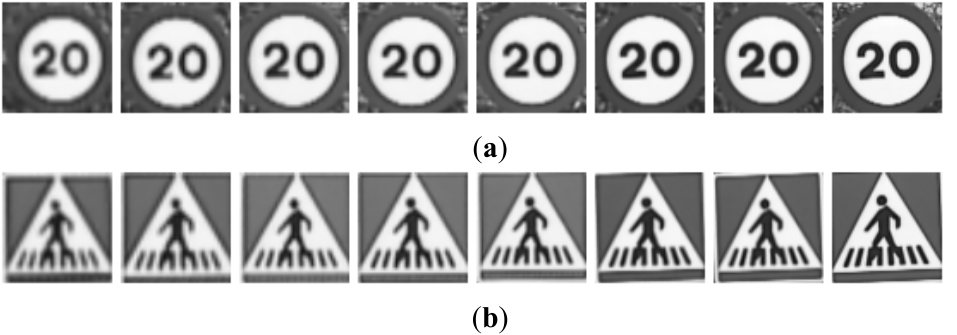
Figure 3. Examples of candidates in Figure 2 after resizing: ( a ) Red road signs. ( b ) Blue road signs.